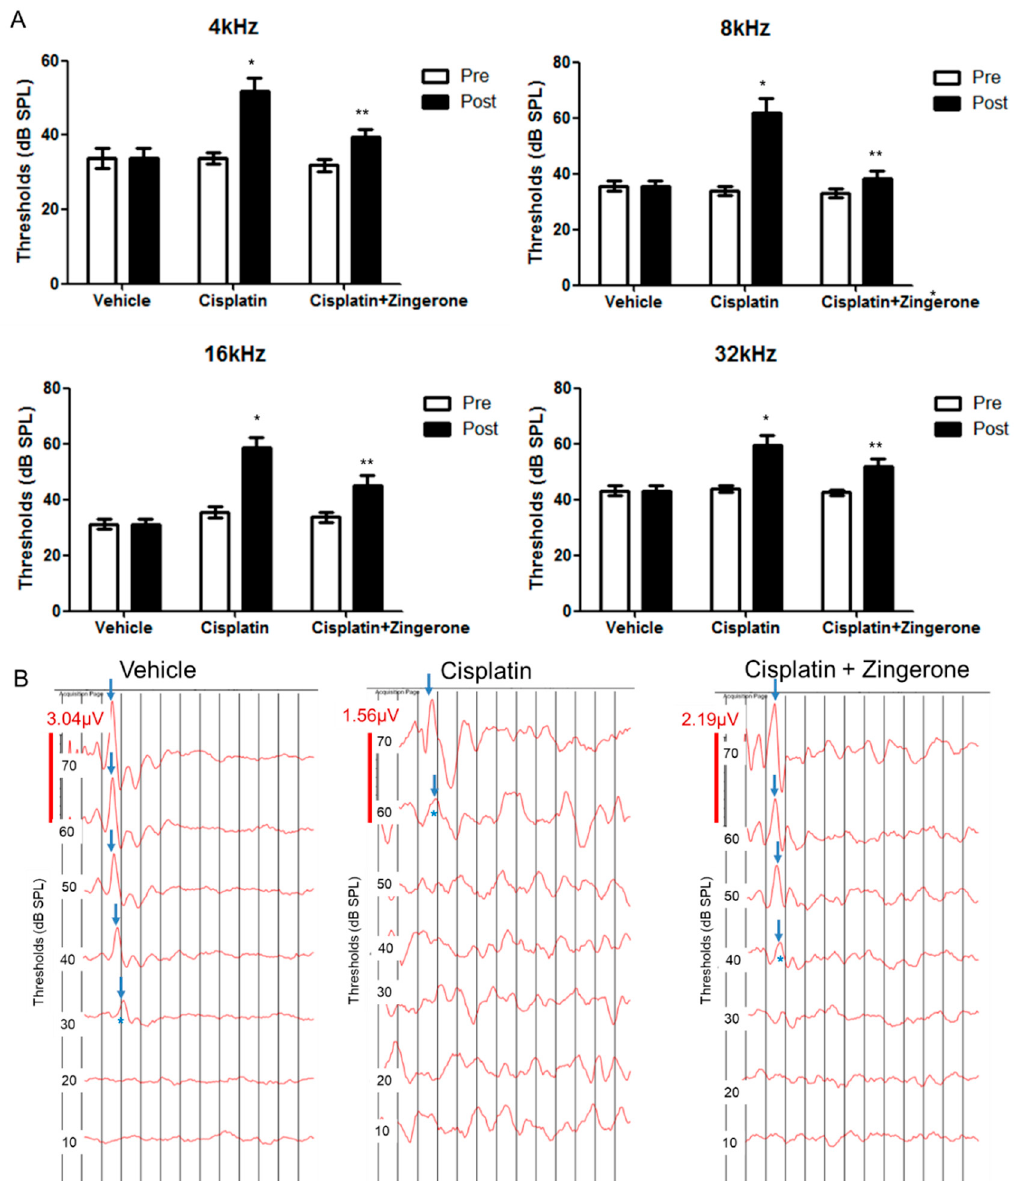
Figure 1. Auditory brainstem response (ABR) thresholds on day 0 (pretreatment) and day 10 (post-treatment). ( A ) The ABR thresholds differed among the three groups (* p < 0.05 for the control vs. cisplatin groups by repeated measures ANOVA with Tukey’s posthoc test). The ABR thresholds in the cisplatin + zingerone group on day 10 were attenuated compared with those in the cisplatin group (** p < 0.05 for the cisplatin vs. cisplatin + zingerone groups by repeated measures ANOVA with Tukey’s posthoc test). The values shown in the graphs are the means ± standard deviations. ( B ) The ABR waveforms at 8 kHz are presented for each group (the arrows indicate wave II; * indicates ABR thresholds).